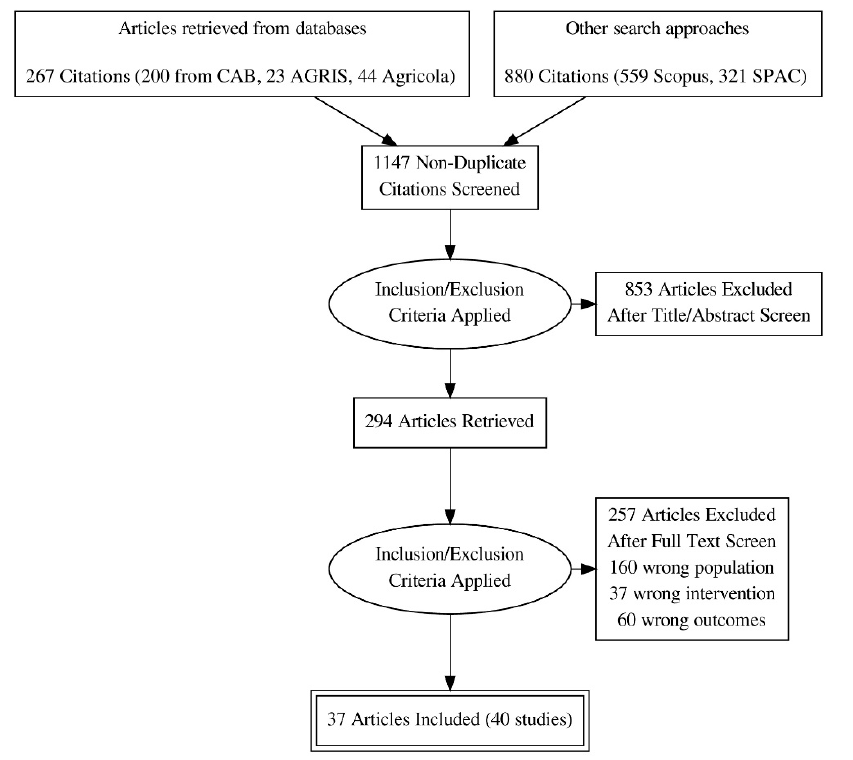
Figure 1. PRISMA flowchart depicting article inclusion of beef cattle housing studies measuring animal welfare criteria .